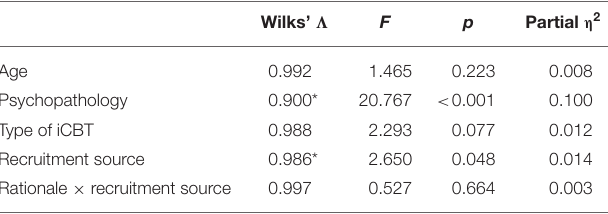
TABLE 4 | Multivariate effects for MANCOVA comparing attitudes toward self-guided and therapist-assisted